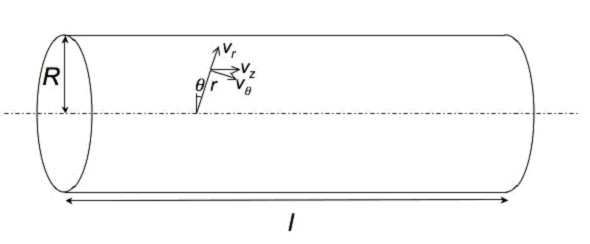
Definition sketch.